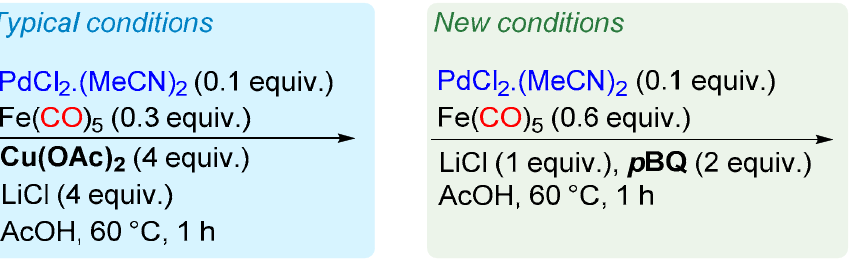
Figure 4. Comparison of known and new conditions for Pd-catalysed carbonylative cyclisation.